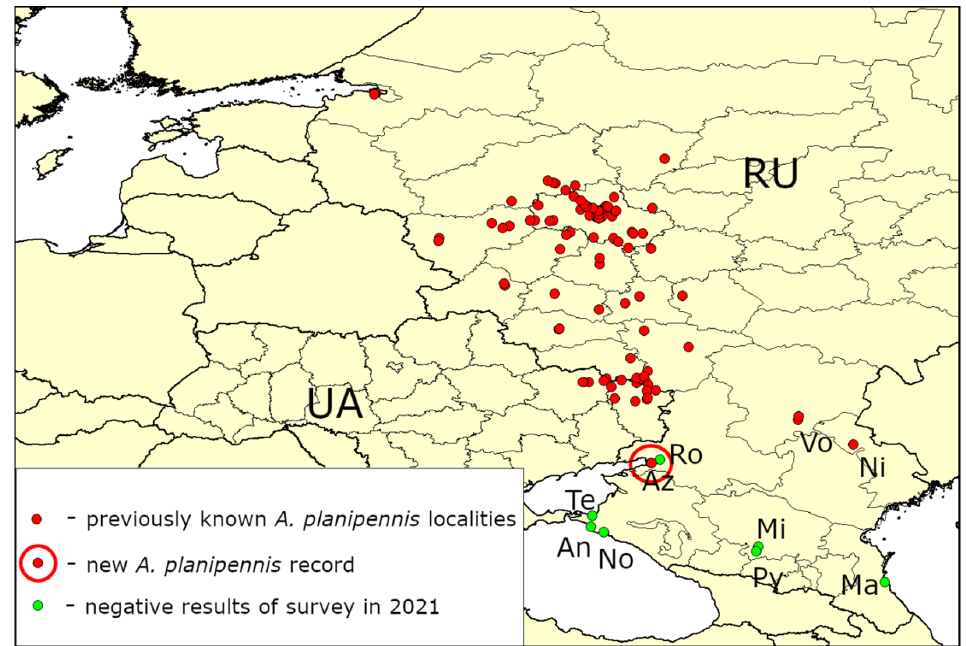
Figure 2. Current range of Agrilus planipennis in European Russia and Ukraine and results of our survey of ash trees in 2021. An—Anapa (Krasnodar Territory); Az—Azov (Rostov region); Ma—Makhachkala (Republic of Dagestan); Mi—Mineralnye Vody (Stavropol Territory); No—Novorossijsk (Krasnodar Territory); Py—Pyatigorsk (Stavropol Territory); Ro—Rostov-on-Don (Rostov region); Te—Temryuk (Krasnodar Territory); Vo—Volgograd (Volgograd region); Ni—Nikolskoe (Astrakhan region). RU—Russia; UA—Ukraine. The list of all localities where A. planipennis has been detected in Europe up to January 2022 is presented in Table S3.